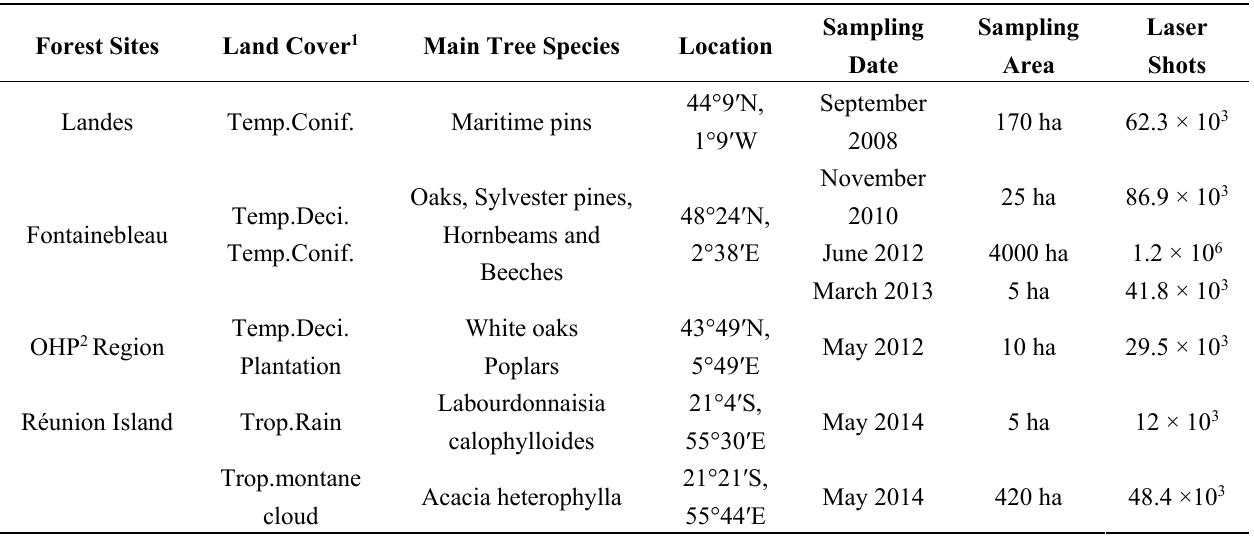
Table 4 . Description of the sites sampled with the airborne lidar ULICE between 2008 and 2014. Forest Sites Land Cover 1 Main Tree Species